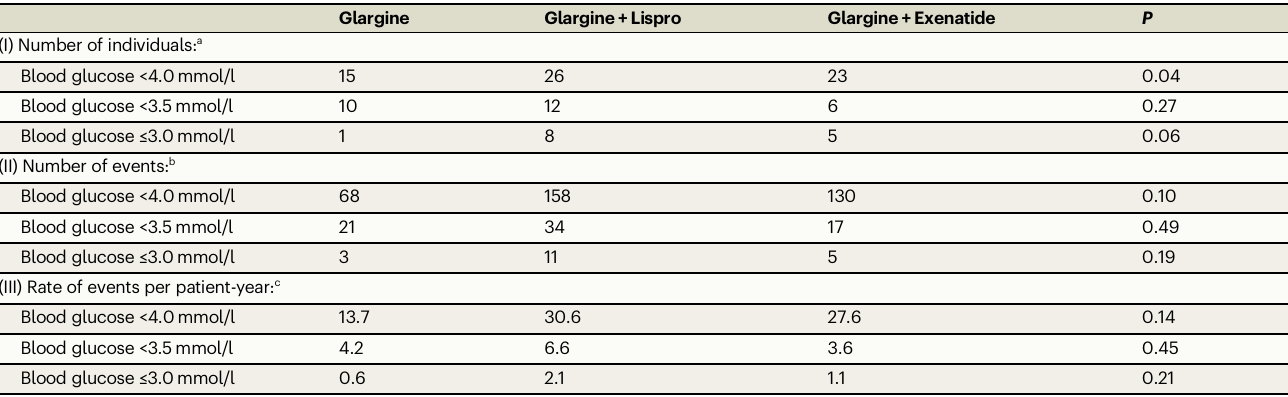
Table 3 | Incidence and rates of hypoglycemia in the treatment arms, with hypoglycemia assessed at three different thresholds in three ways: (i) number of individuals, (ii) number of events, and (iii) rate per patient-year Glargine Glargine+Lispro